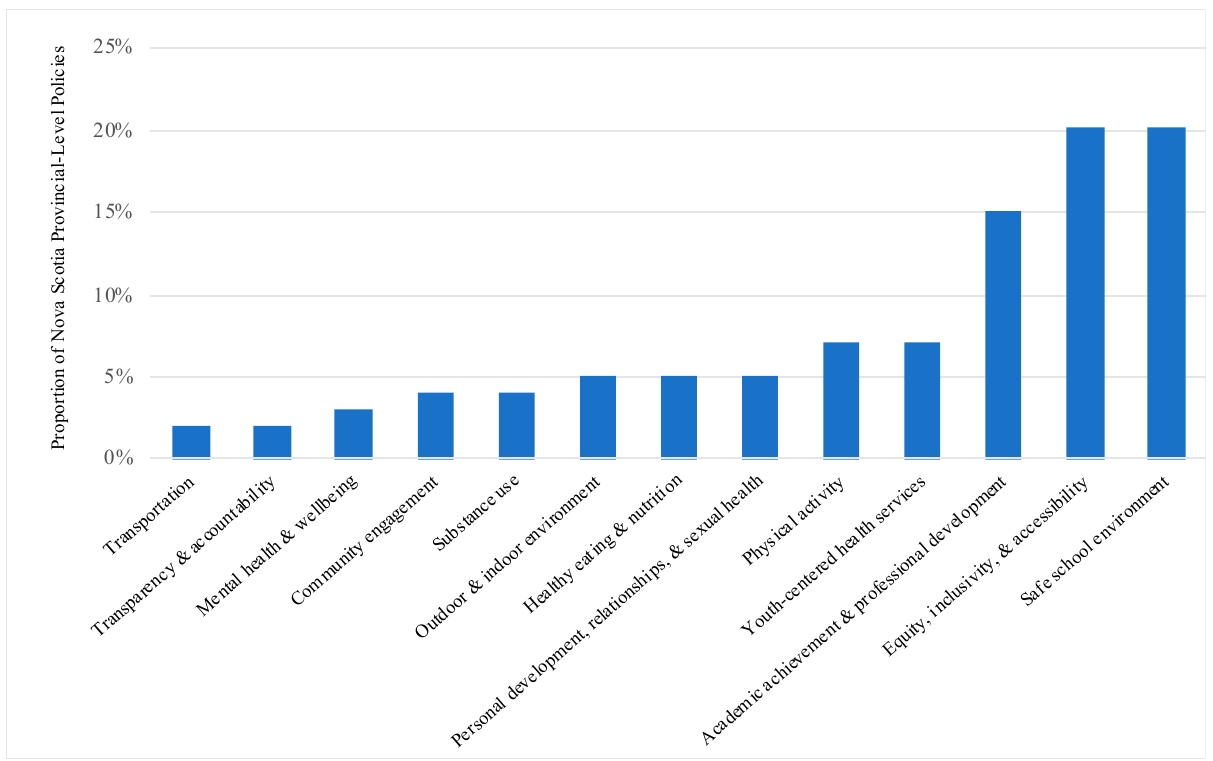
Figure 1. Proportion of Nova Scotia Provincial-Level Policies According to Health Promotion Topic Represented. Policies developed by Nova Scotia provincial government departments, including Education and Early Childhood Development; Nova Scotia Health; Communities, Culture and Heritage; Health and Wellness; Justice, and Transportation and Infrastructure Renewal, are proportionally represented according to the health promotion topic(s) they were found to align with.